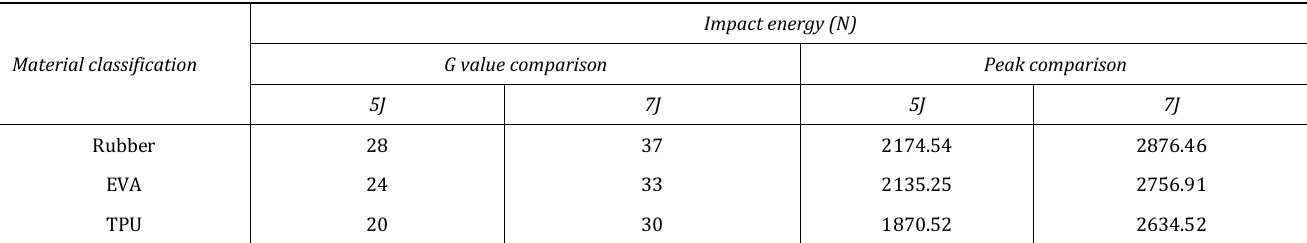
Table 2: Table of the maximum peak value and G value of different impact energy